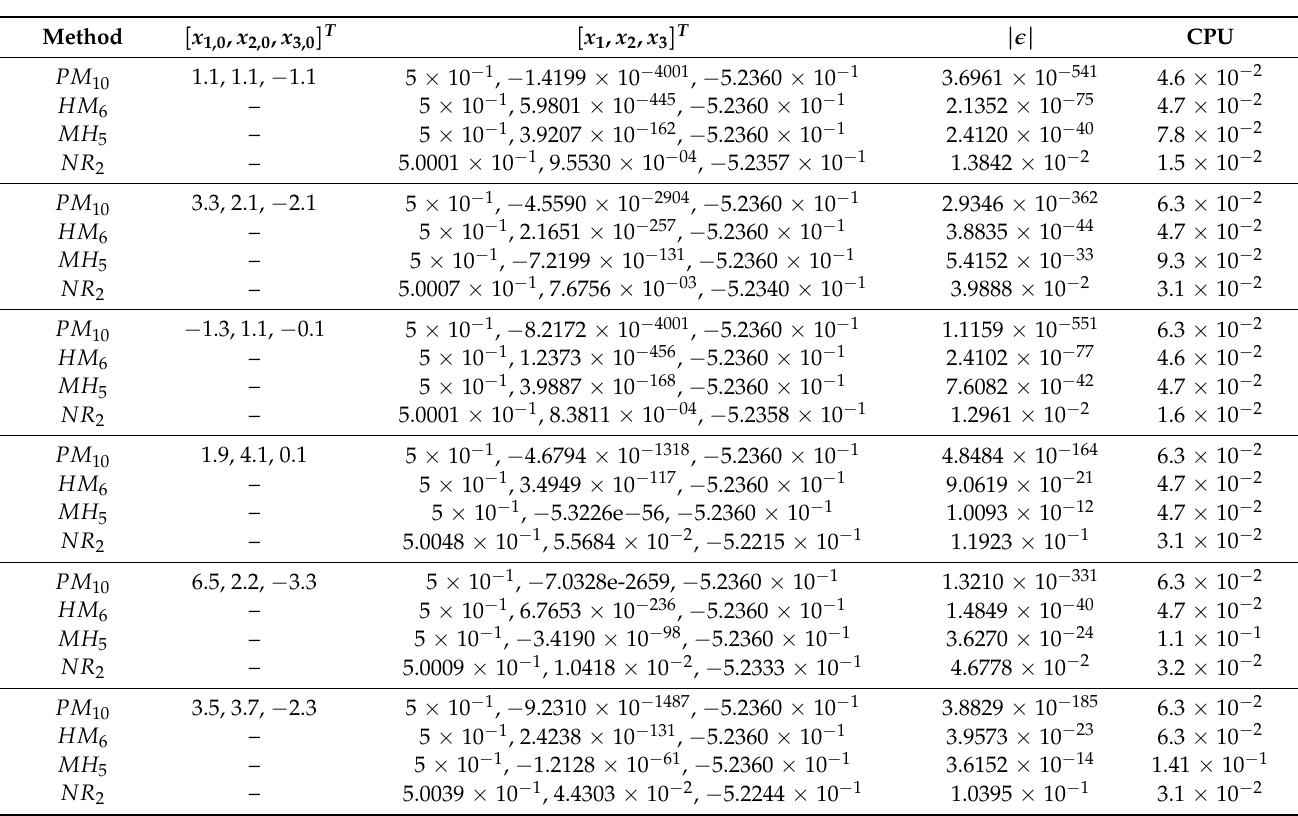
Table 13. Numerical results for problem